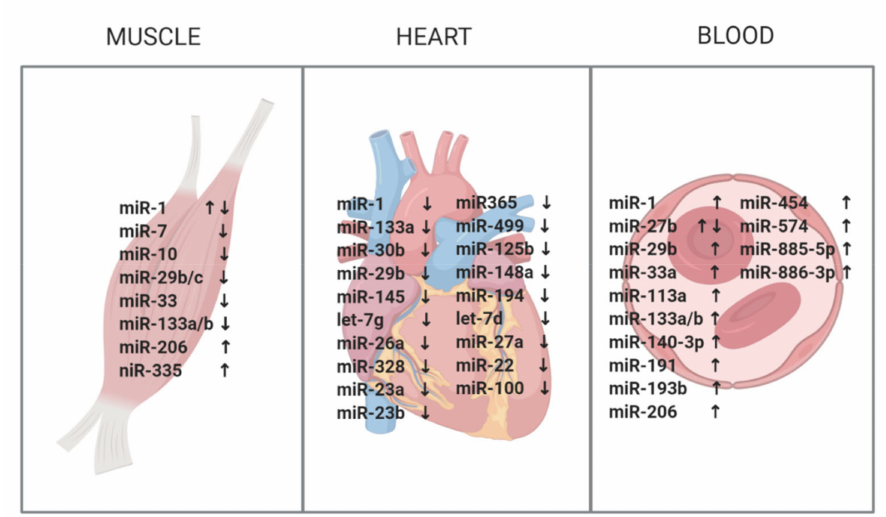
Figure 1. A summary of the studied miRNAs in skeletal muscle, heart, and blood. ↑ = upregulation, ↓ = downregulation. Created with